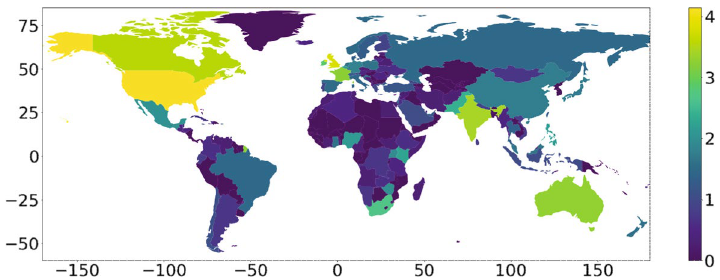
Fig. 3 Geographic distribution of the seed tweets. Colors show the base 10 logarithm of the tweet